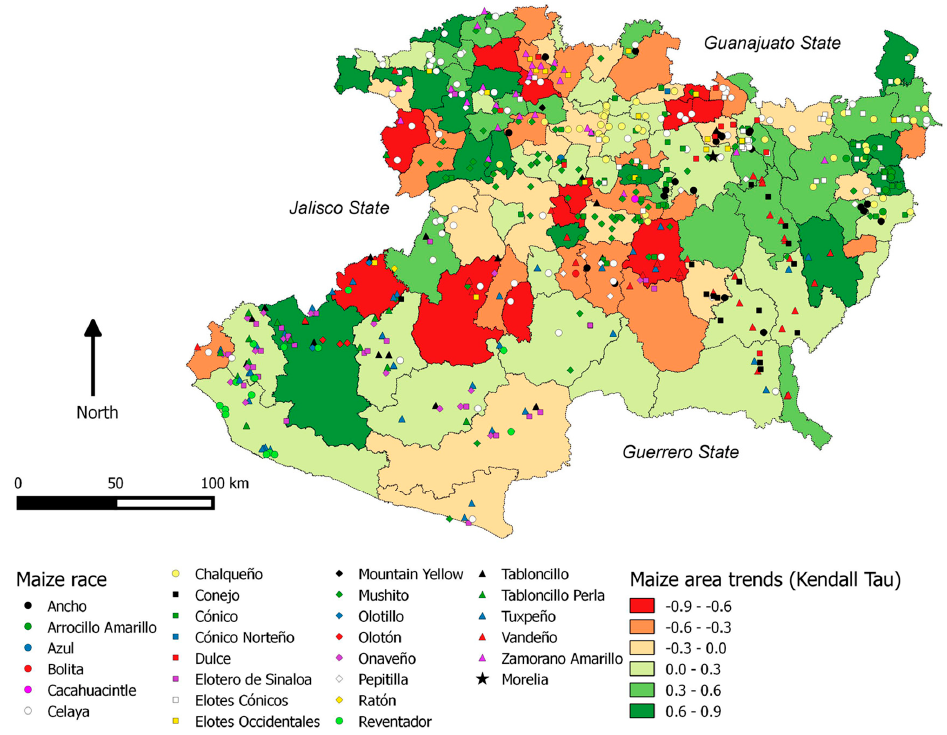
Figure 4. Maize planted area trends from 1950 to 2015 and maize race collections. Trends are expressed by tau coefficient from a Kendall correlation.